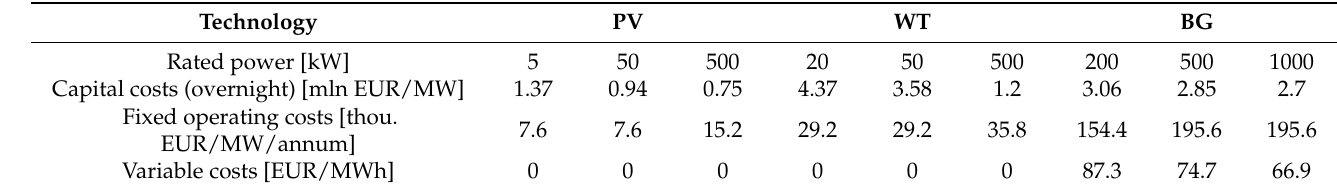
Table 2. RES costs [24–26].